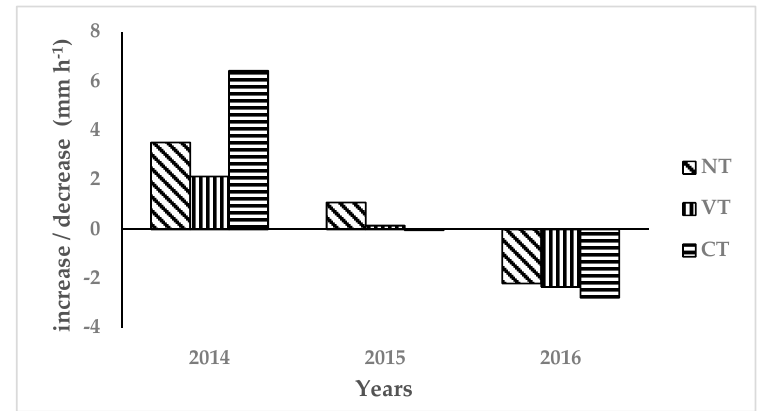
Figure 8. Change of saturated hydraulic conductivity for each tillage system, having as a reference the values of 2013.